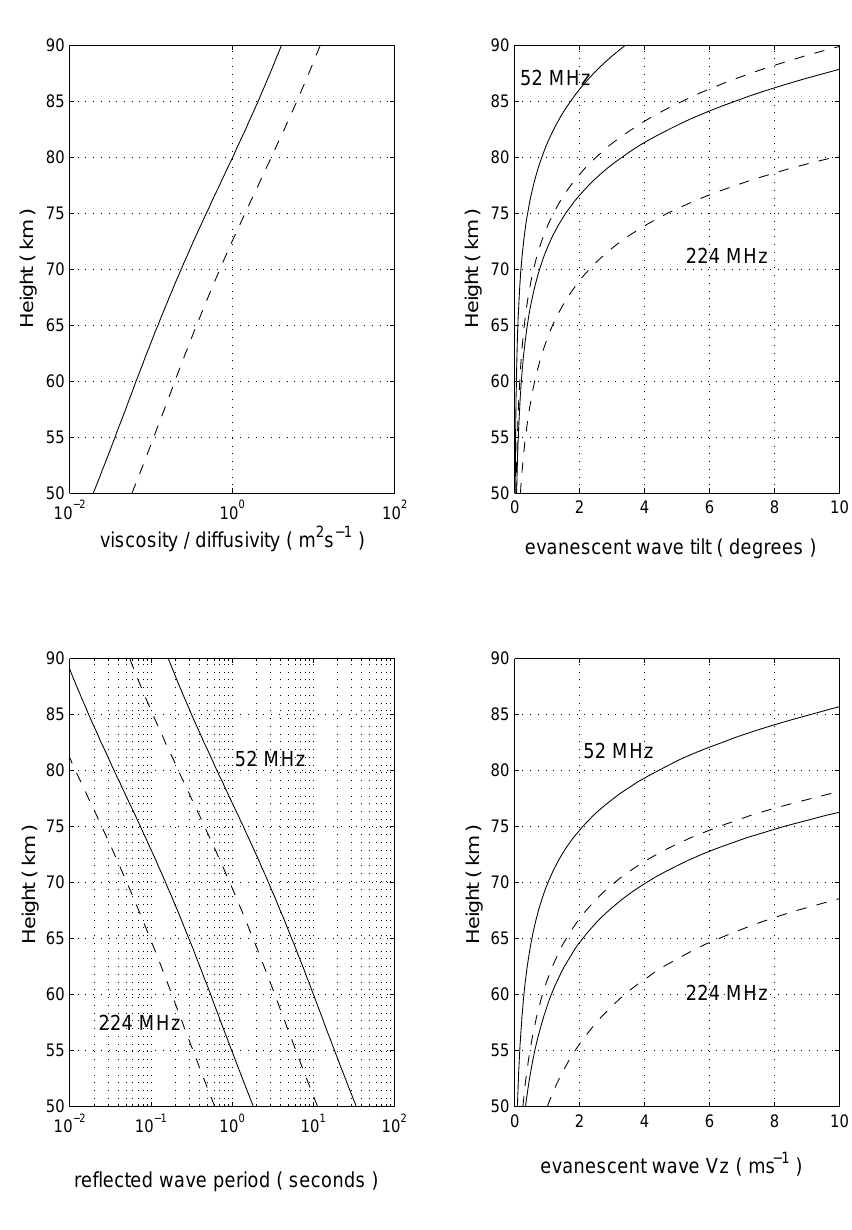
Fig. 14. Upper-left panel: solid line shows kinematic viscosity for midwinter, 60degN latitude, calculated from the MSIS90E neutral atmosphere model (Hedin, 1991). This line also indicates electron diffusivity in the case when only positive molecular ions are present. The dashed line indicates a factor 3 increase in electron diffusivity such as would be produced if the ratio of negative-ions to electrons ( 3) is 2 (Hill, 1978). Solid and dashed lines in the other panels show calculated values based on these two diffusivity profiles. Lower left panel: calculated acoustic wave periods which will produce evanescent waves matching the radar Bragg scale for radars at 224MHz and 52MHz. Upper-right panel: calculated tilt of the evanescent-wave wave-fronts, relative to the reflecting surface. Lower-right panel: calculated drift speed of the evanescent-wave wave-fronts, away from the reflecting